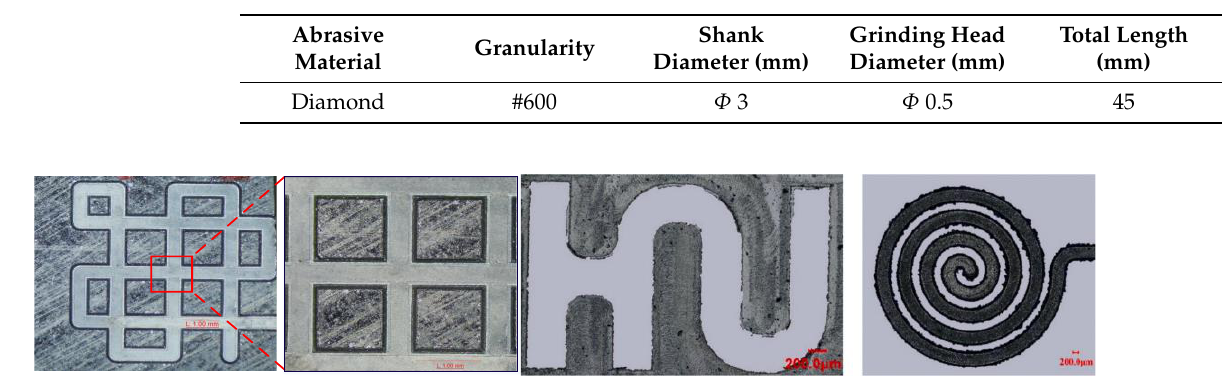
Table 6. Parameters of the micro-grinding rod used in the test.